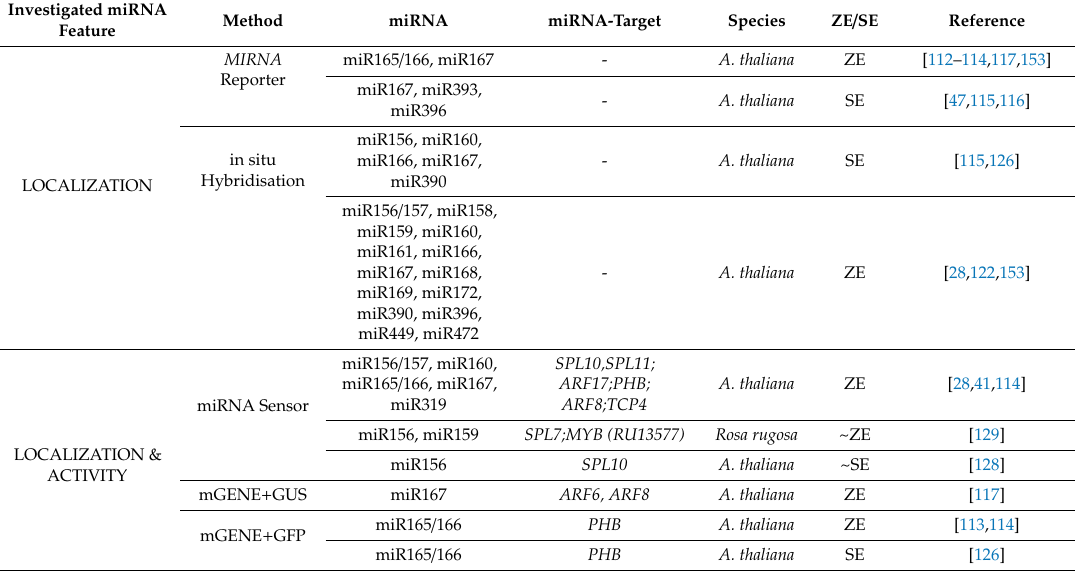
Table 2. The tools that have been successfully used in the functional analyses of miRNAs during zygotic (ZE) and somatic embryogenesis (SE). Some of the analyses are considered to be indirect (~) approaches forrevealingthefunctionofmiRNAsinthementionedprocess.